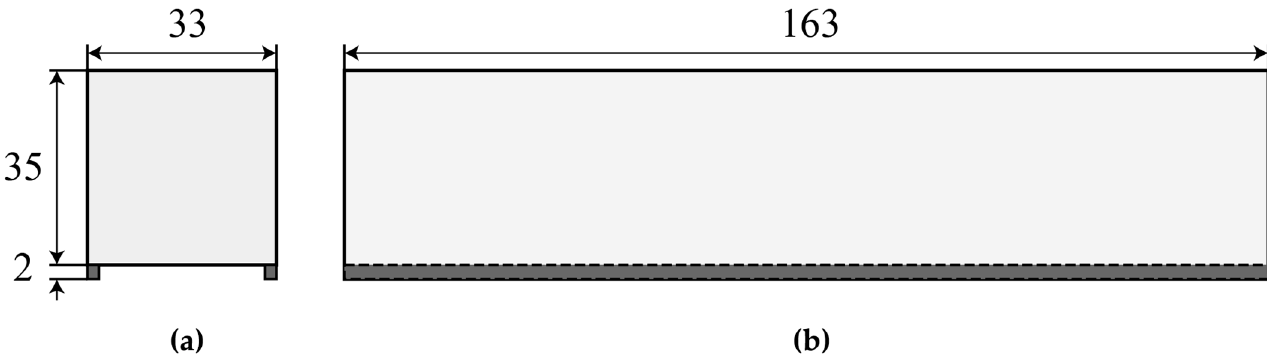
Figure 2. Dimensions of individual acrylic debris block (unit: mm): ( a ) plan view; ( b ) elevation view.